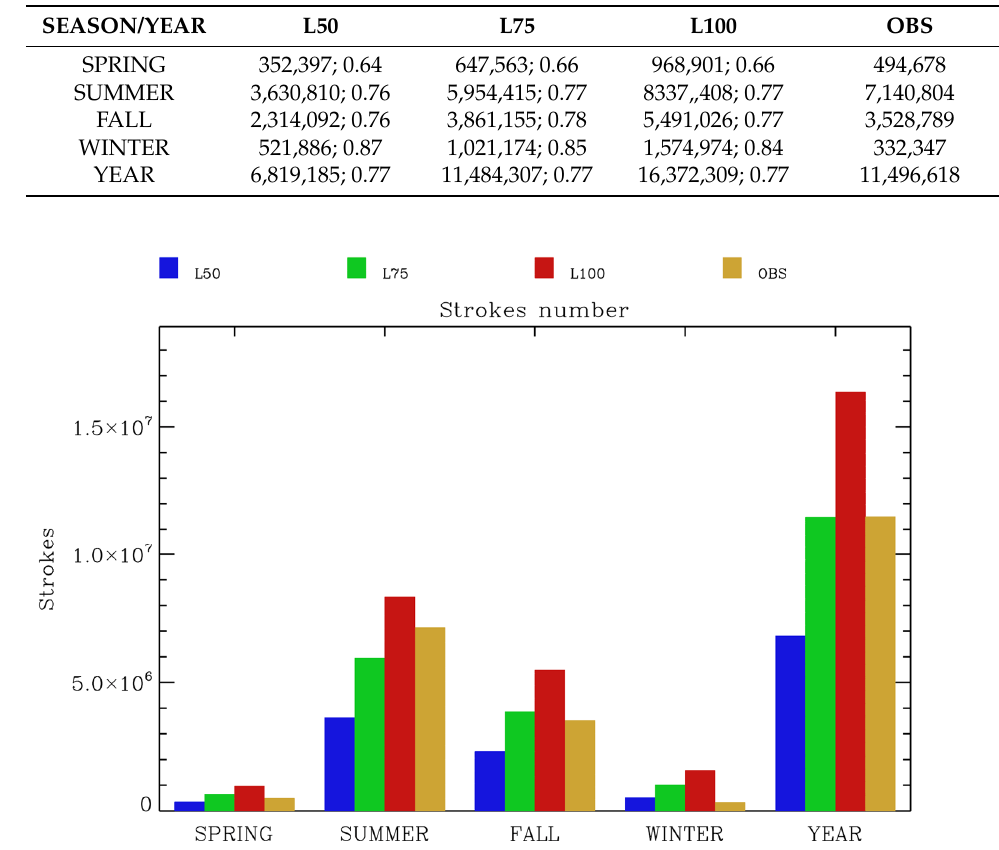
Figure 4. Total number of strokes simulated (L50, L75, L100) and observed (OBS) for each season and for the year. The number of cases considered are shown in Table 1 .